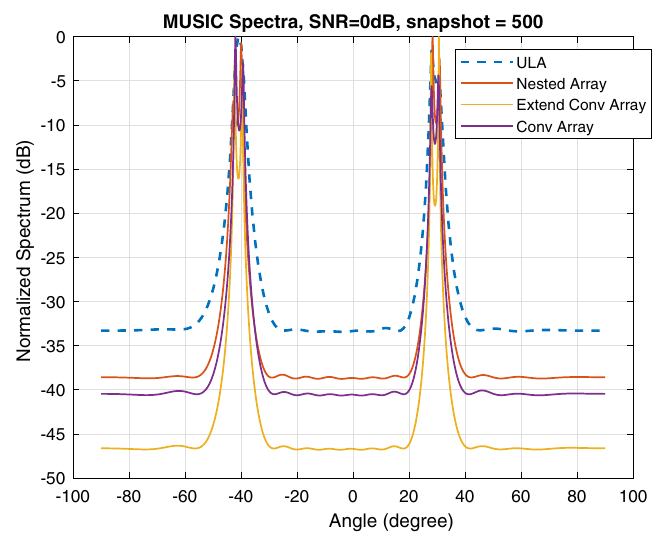
Fig. 4 Difference co-array of the (2, 3) 2D extended sparse conv